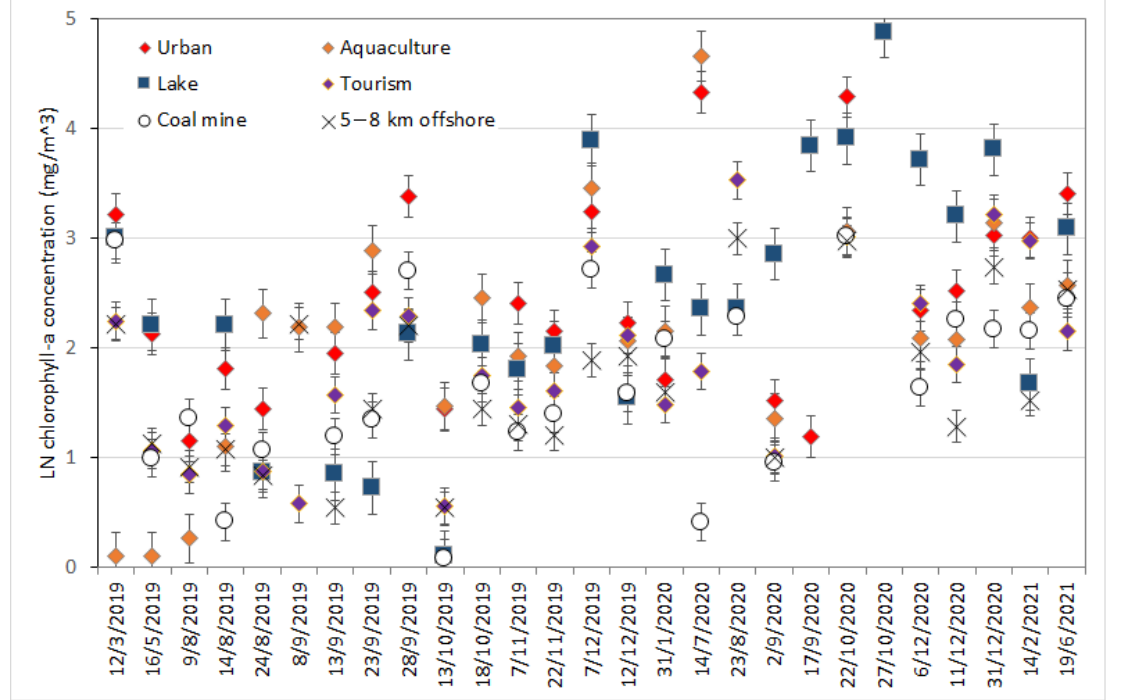
Figure 4. Comparison of different locations representative of anthropogenic activities with chloro- phyll-a concentrations retrieved from Sentinel-2 data presented at the natural logarithm (Ln)